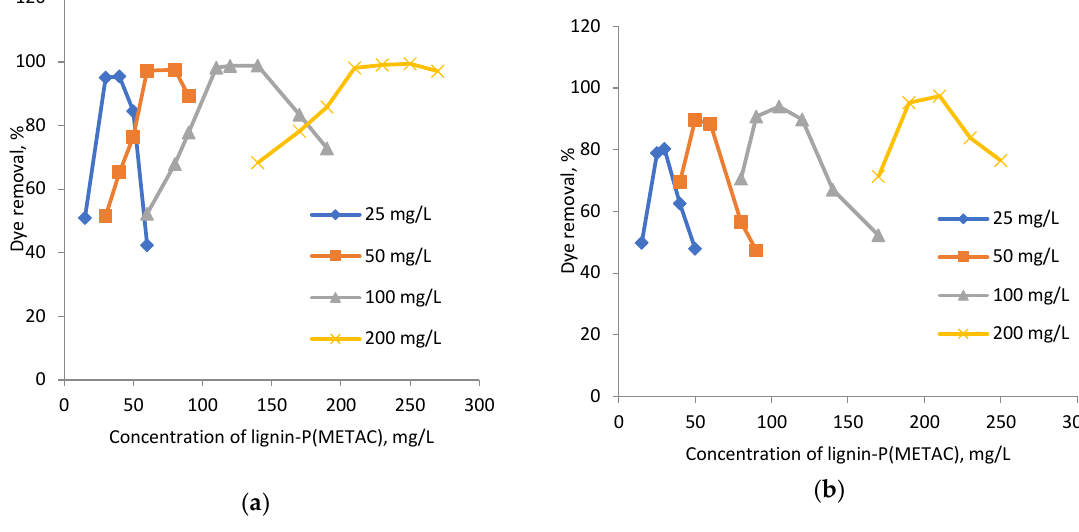
Figure 4. Effect of dye concentration on dye removal ( a ), RB5; ( b ) RO16 at pH 6 using sample 4.